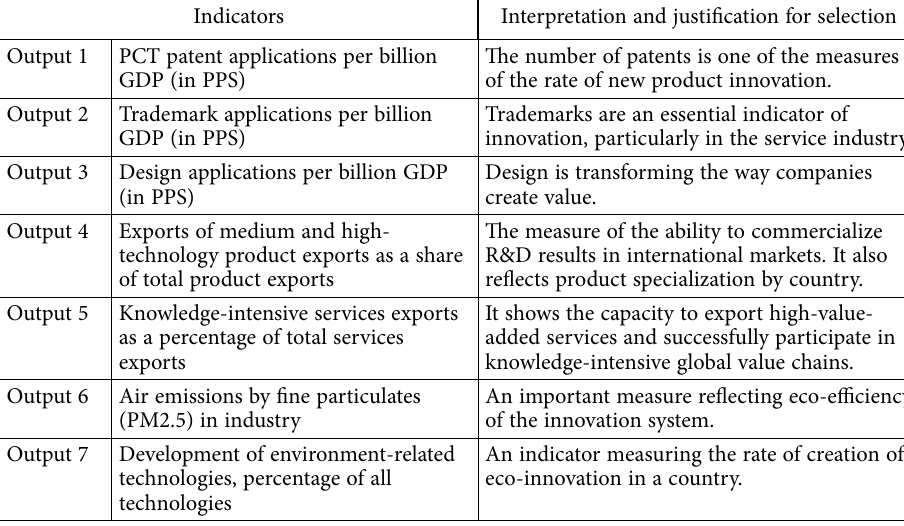
Table 2. Indicators used to measure innovation position (output subindex) of an economy (source: author’s concept based on the European Innovation Scoreboard 2021 methodology) Indicators Interpretation and justification for